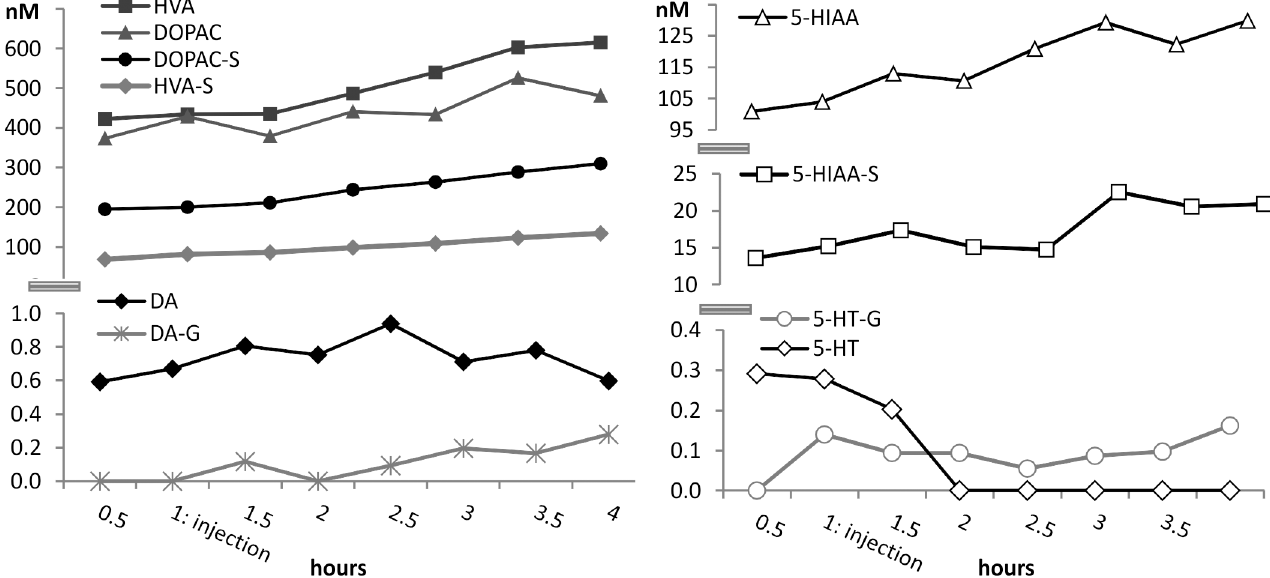
Fig 3. Concentrations of the neurotransmitters (Left: dopamine metabolites, right: serotonin metabolites) during the test in rat brain microdialysates in one of the test animals (Rat 6).